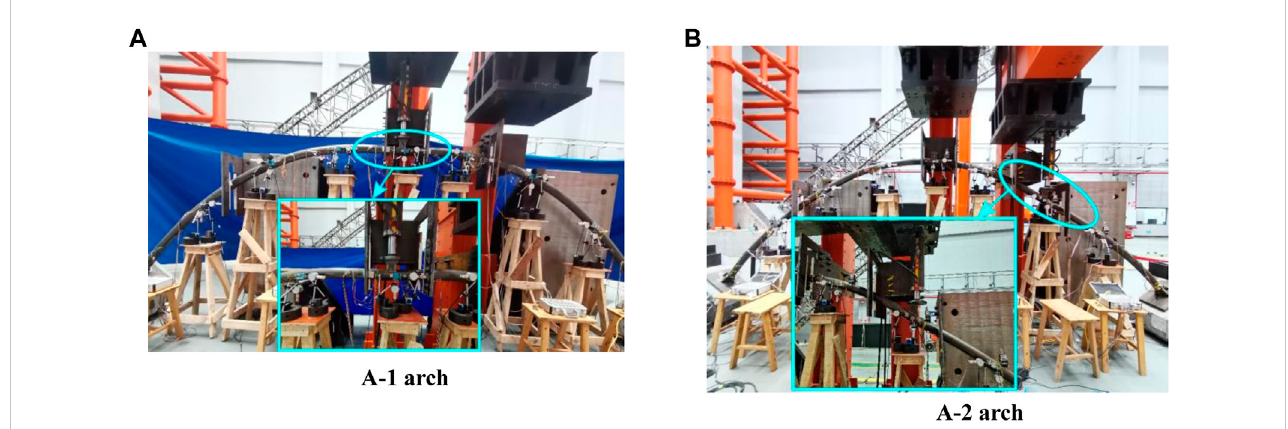
FIGURE 12 State after destruction: (A) A-1 arch; (B) A-2 arch.